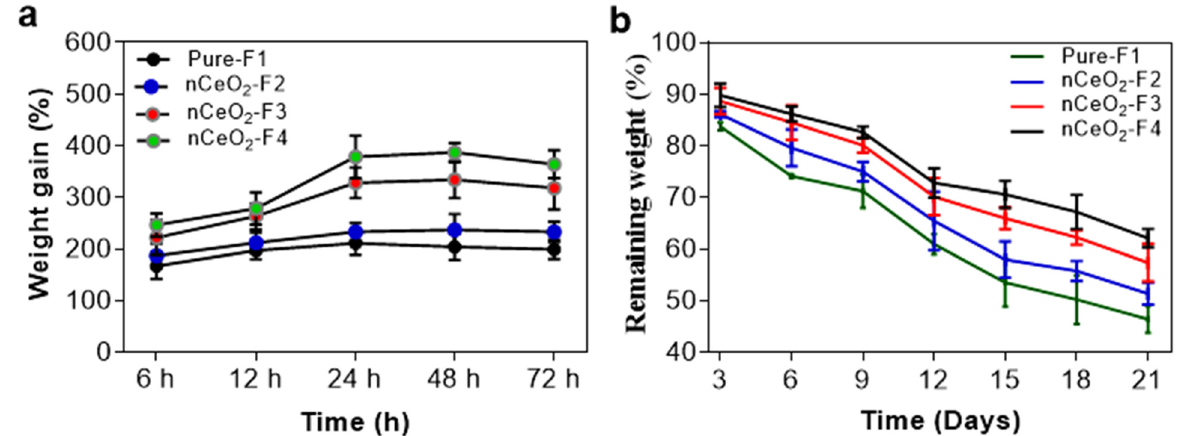
Figure 4. ( a ) Swelling and ( b ) biodegradability of the developed nCeO 2 -loaded NFs.